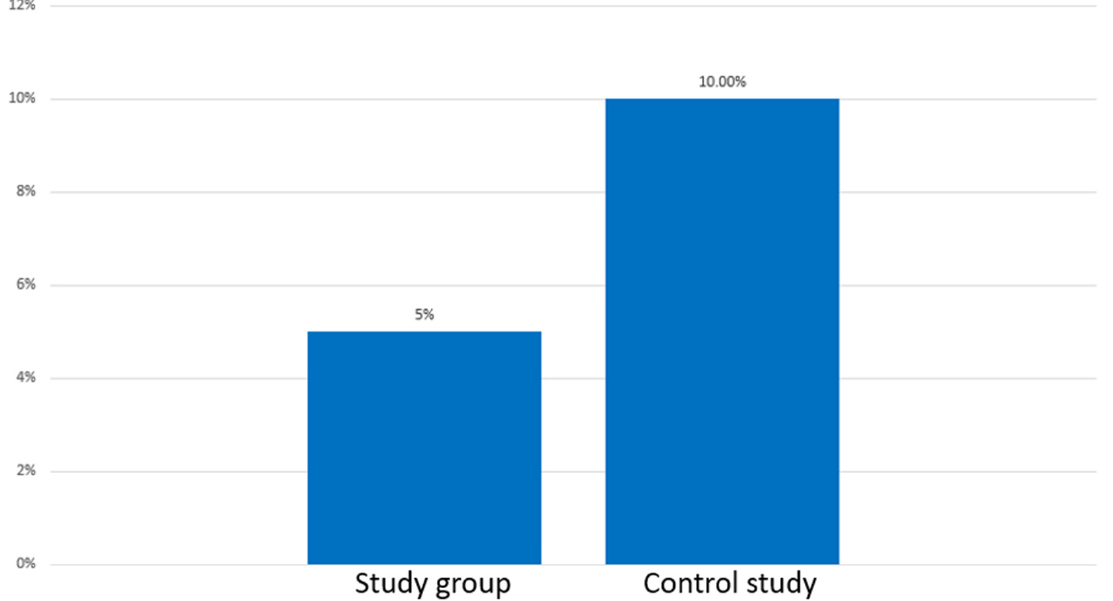
Figure 4. The proportion of patients who underwent reoperations, % of the total number of group participants.